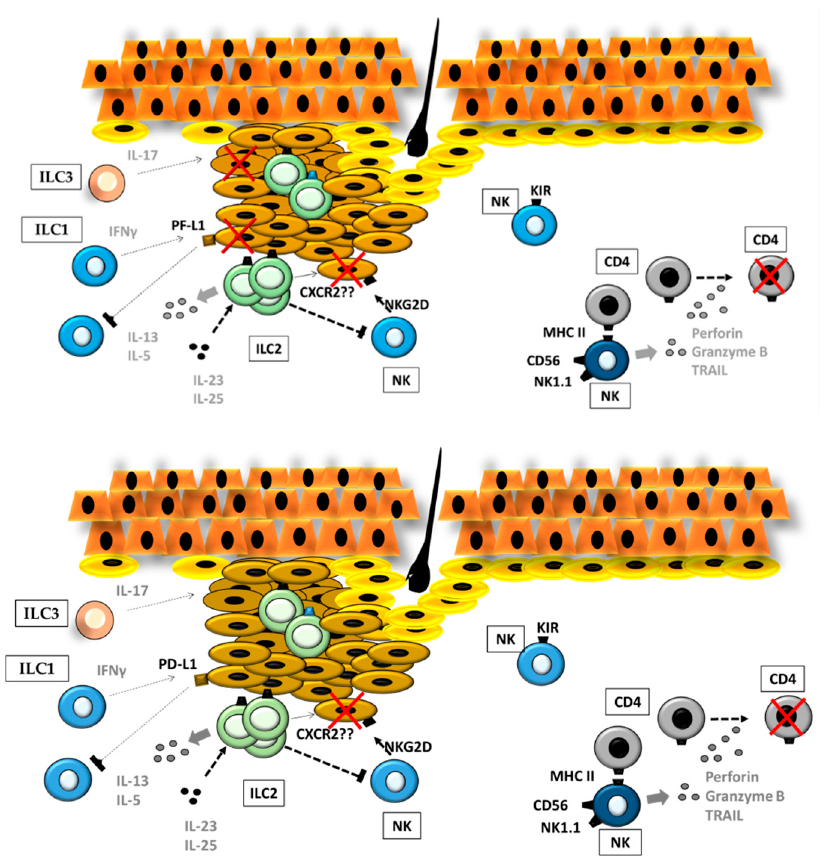
Figure 5. ILCs in melanoma. During melanoma progression, different ILC subsets maintain active crosstalk, resulting in either antitumoral or protumoral responses, not only by direct action on tumor cells but also by acting on other ILCs (left). Moreover, ILCs modulate CD4 + T-cell activity and, thus, influence the adaptive immune response through MHC class II. MHC—Major histocompatibility complex.